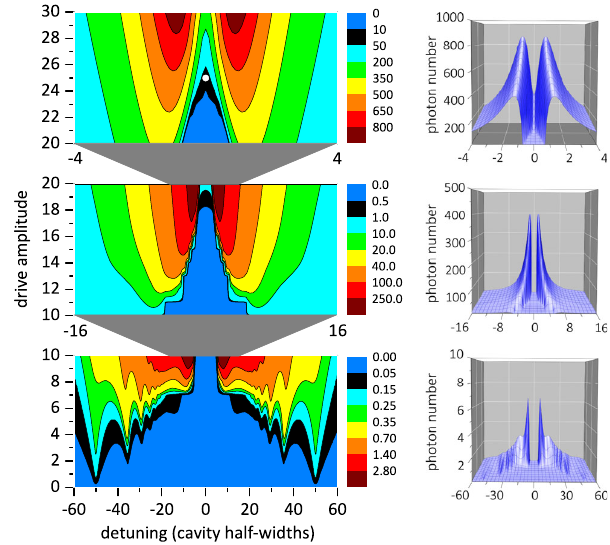
FIG. 1. Mean photon number in the steady state as a function of drive detuning Δ ω = κ and amplitude E = κ for a dipole-coupling strength g= κ ¼ 50 . The white dot in the uppermost panel locates the critical point at Δ ω = κ ¼ 0 and E = κ ¼ 25 . Each panel on the left shows contours of the surface plot on the